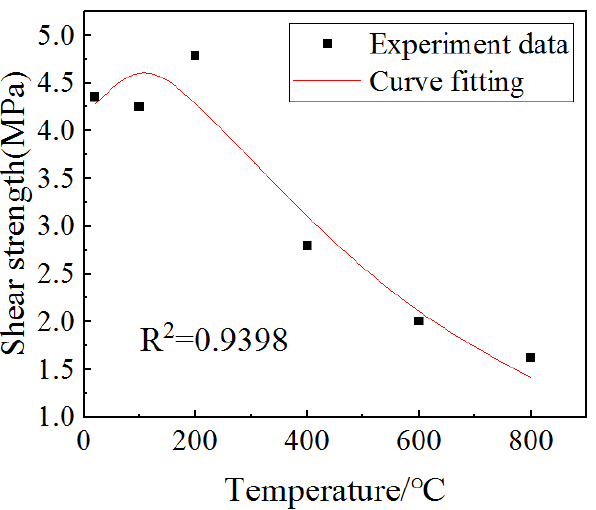
Table 7. Shear strength of concrete after different heated temperatures.